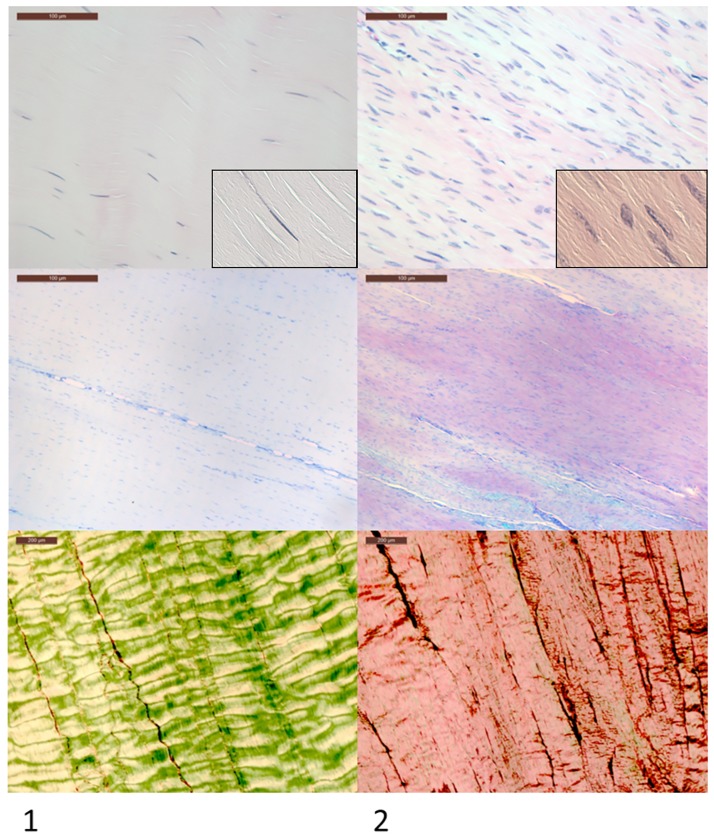
Histological appearance of normal and healing tendon.Column 1 shows the typical microscopic appearance of normal tendon in contrast with healing transected tendon in Column 2. Magnified cell morphology images are displayed in inset panels. Contralateral uninjured tendons were used as controls as well as a single sham operated subject in each group. Transected tendon has markedly increased cellularity with a more rounded cell morphology (seen in inset panels), increased proteoglycan accumulation (purple staining) and collagen fibre malalignment under polarized light. The cellular rounding and increased proteoglycan staining is indicative of a chondroid phenotype.